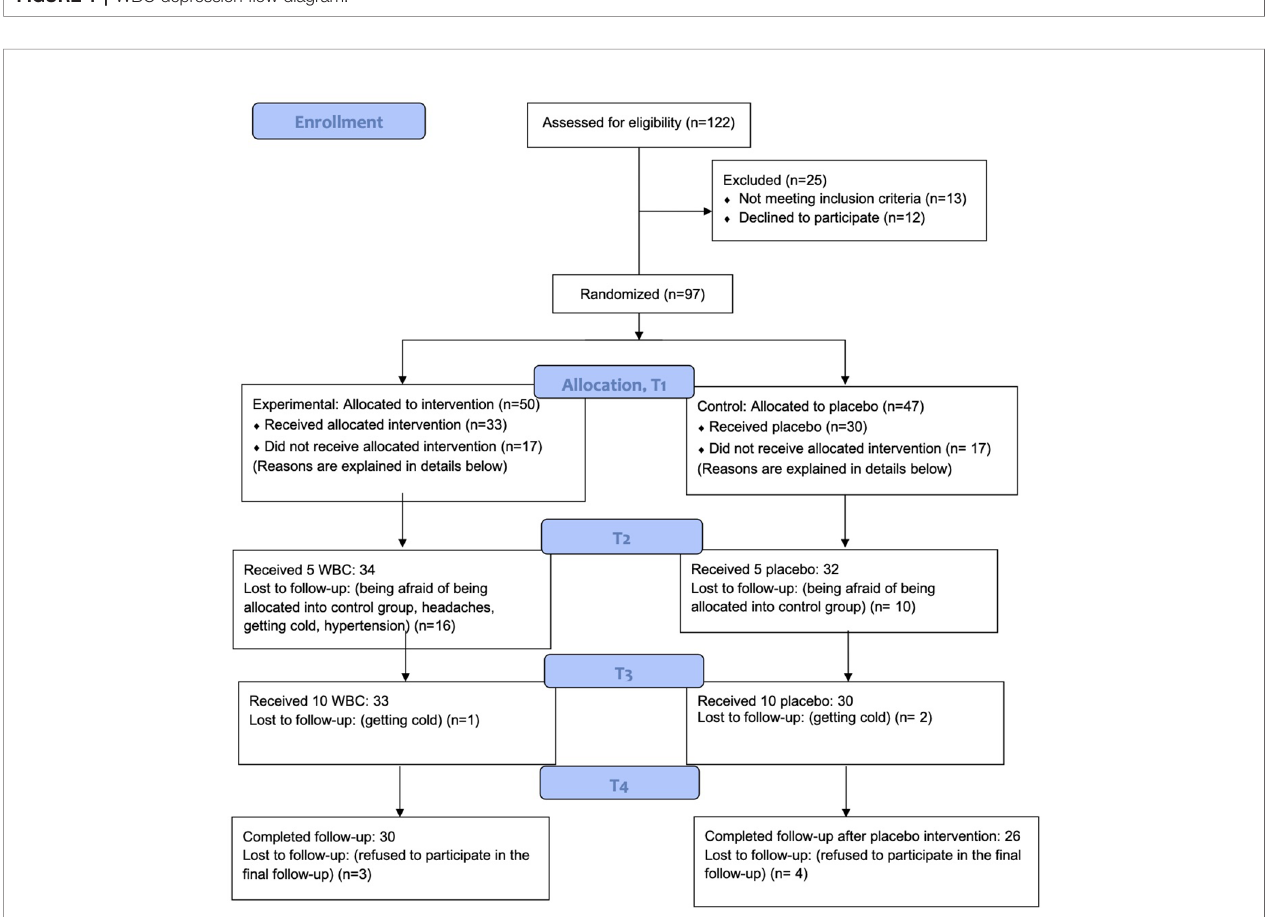
FIGURE 2 | WBC study design.